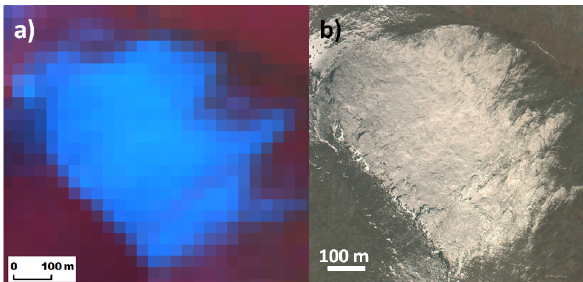
Figure 9. Glacier-like seasonal snow cover seen in false-colour (bands 7, 4, and 2 as RGB) composite imagery at path 140 row 41 (27.984 ◦ N, 87.657 ◦ E), taken on 17 October 2001 (a) , and Google Earth, © 2014 DigitalGlobe screenshots of the same location (b) . We can distinguish between such snow cover and glacier ice using high- resolution Google Earth TM imagery, which reveals that the surface is undulating and has the appearance of thin snow on a rock